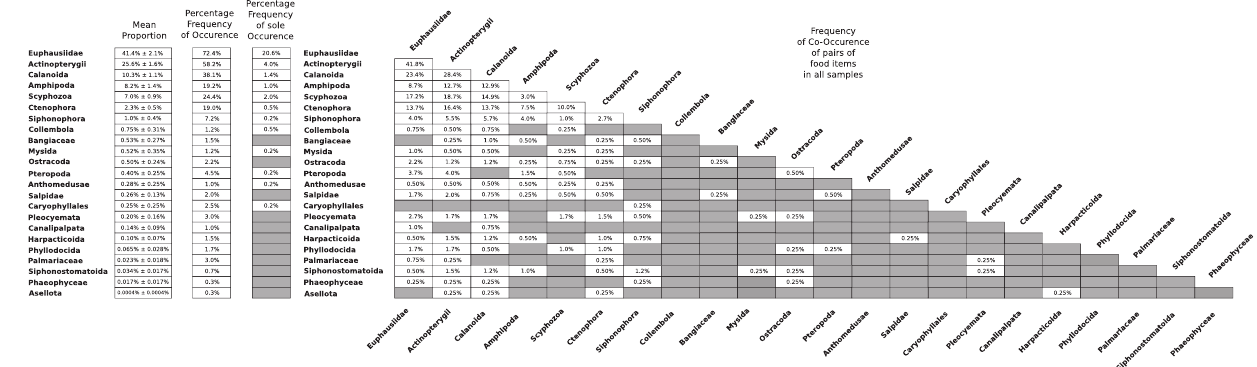
Figure 2. Summary of all diet items. Numerical summaries of DNA based diet analyses for all samples in this study. The food species groups are ranked in order of mean proportion across all samples. The percentage frequency of occurrence of food groups in all samples and the percentage frequency of samples that only had one food item are given. The frequency with which samples in the population had co-occurrence of food items on the Y and X axes of the grid is given. Grey squares indicate no